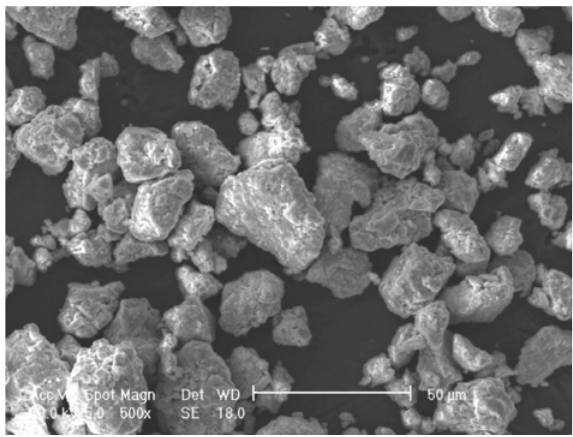
Figure 4: Morphology of CuFe(alumina) powder after 60 h of milling.